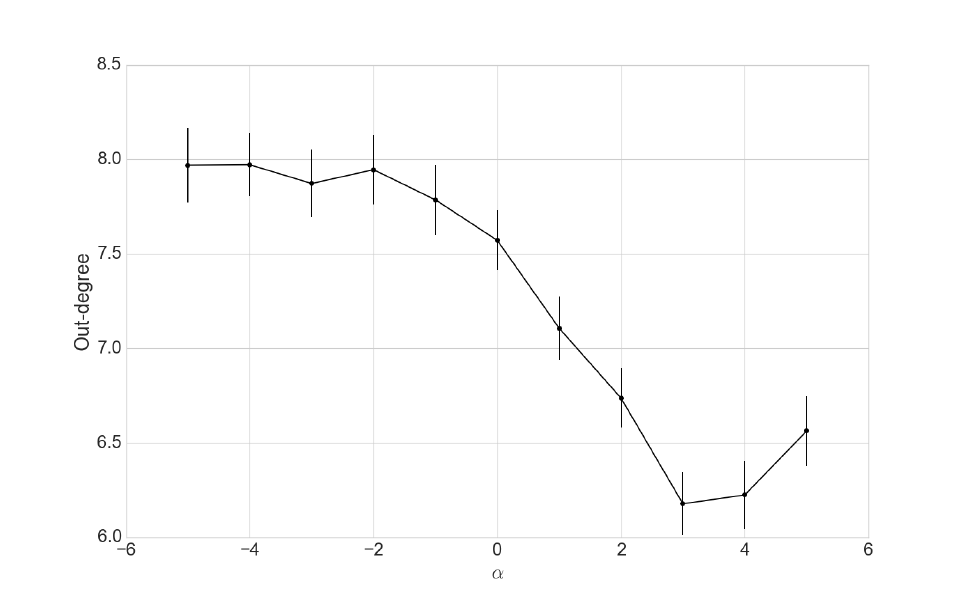
Figure 9. Risk preference α vs. average out-degree.